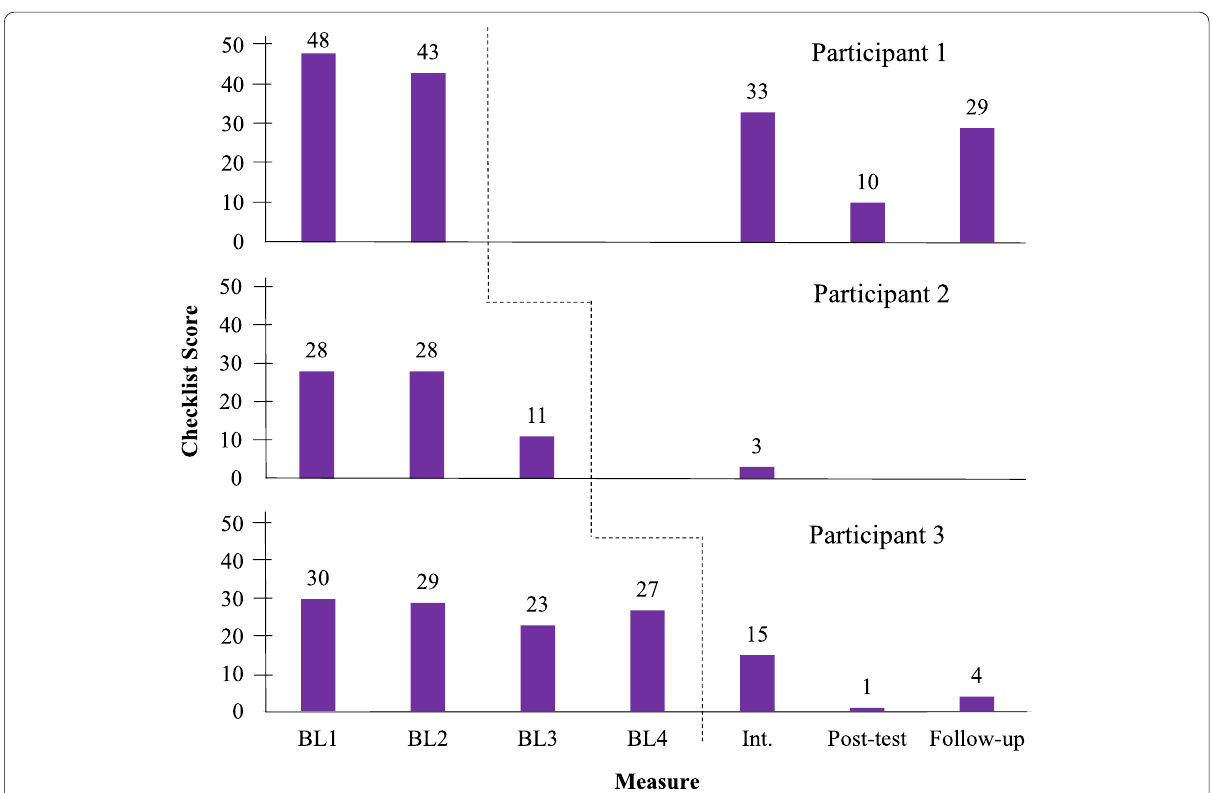
Fig. 3 Complaints Checklist Scores. Note : BL